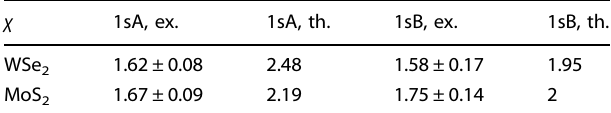
Table 1. The ratio χ = Δ E OS / Δ E BS of OS to BS shifts for 1sA and 1sB excitons, derived experimentally (ex.) and calculated theoretically